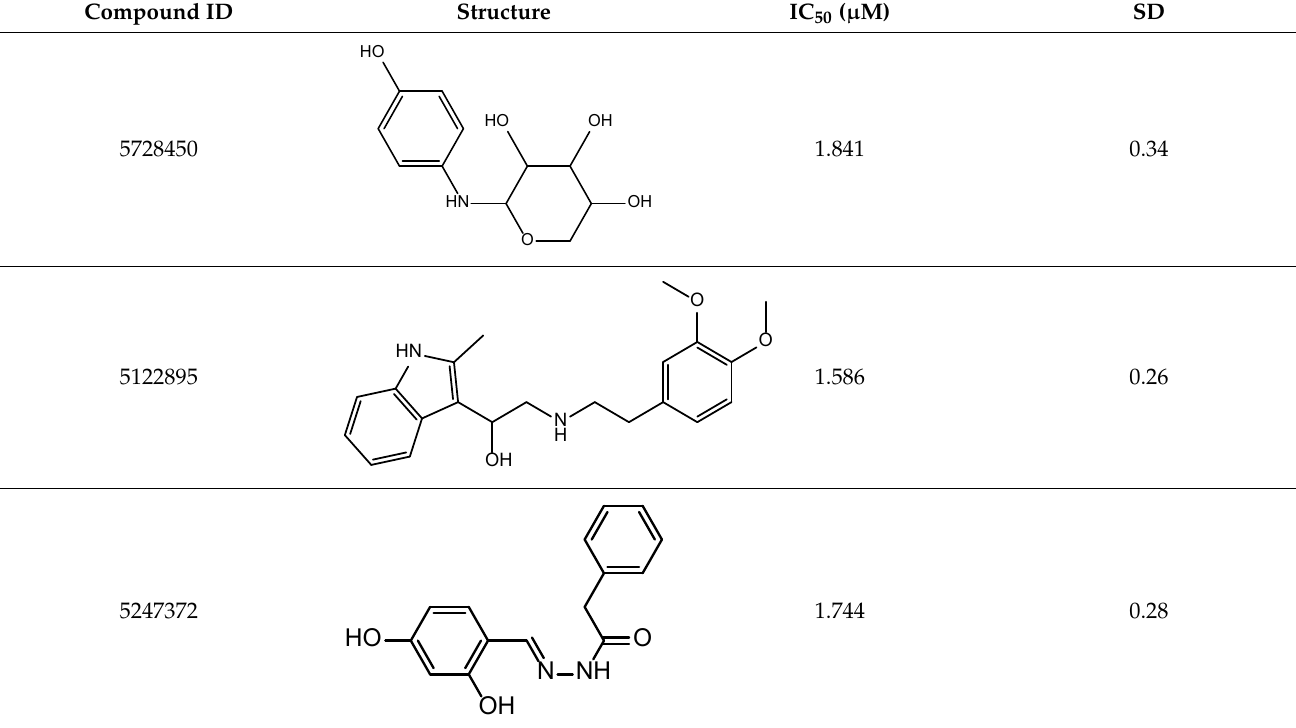
Table 2. Top five compounds, as identified by their compound ID, their structural formula, and the IC 50 (in µM), as determined from the nSMase2 enzymatic assay. Structure